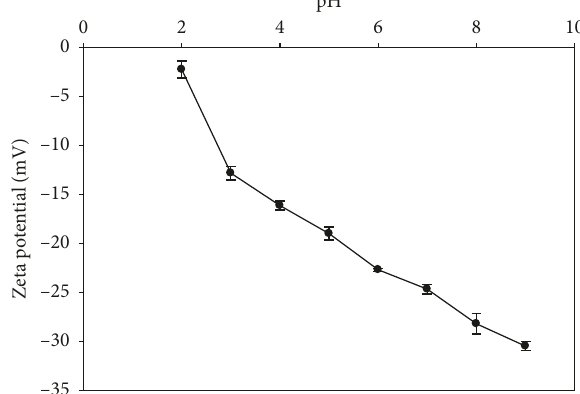
Figure 3: Zeta potential of Grewia spp. powder at different pH.